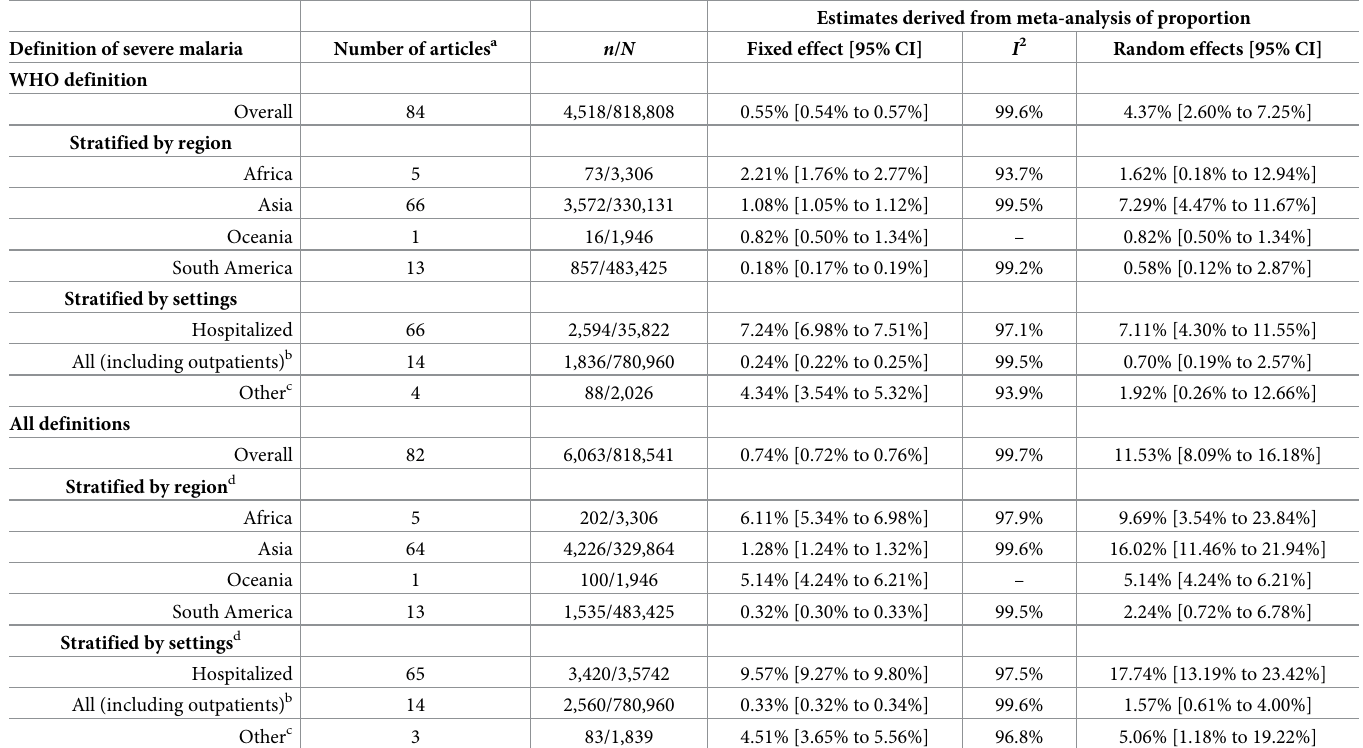
Table 2. Estimating the proportion of vivax malaria that were classified as severe in studies eligible for inclusion in the